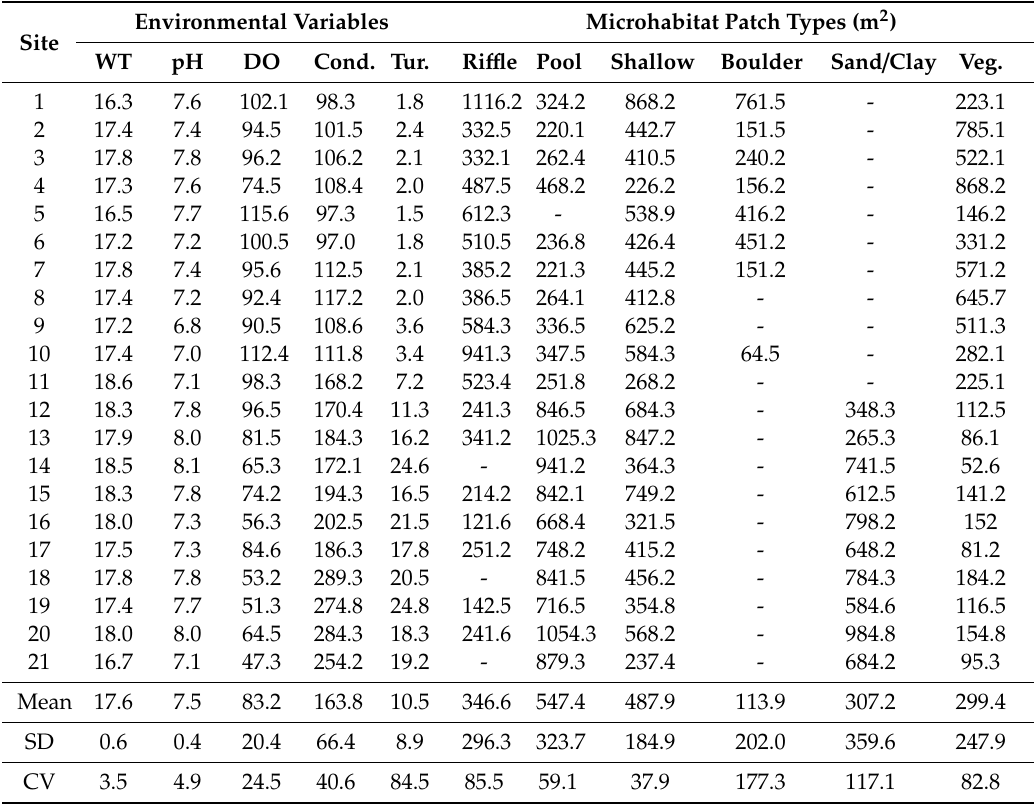
Table 2. Environmental variables and microhabitat patch types at 21 study sites located in the upper parts of the Geum River. WT, water temperature ( ◦ C); DO, dissolved oxygen (%); Cond., conductivity ( µ g / L); Tur., turbidity (NTU); Veg., vegetated; SD; standard deviation; CV, coe ffi cient of variation